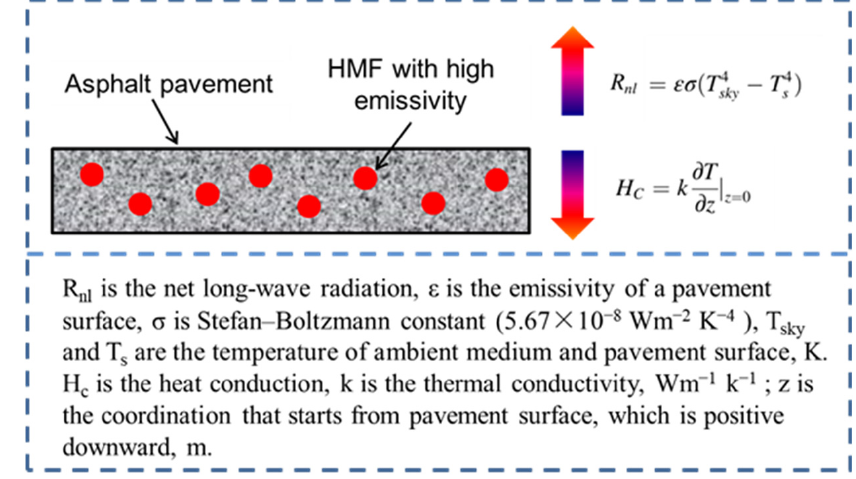
Figure 14. Surface temperature-reducing mechanism of HMF.